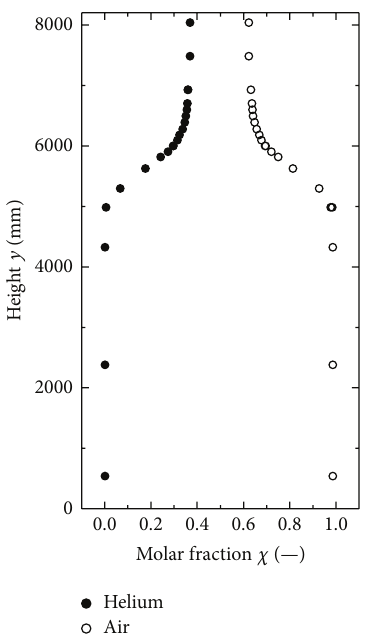
Figure 3: Initial air and helium molar fraction as a function of height in the